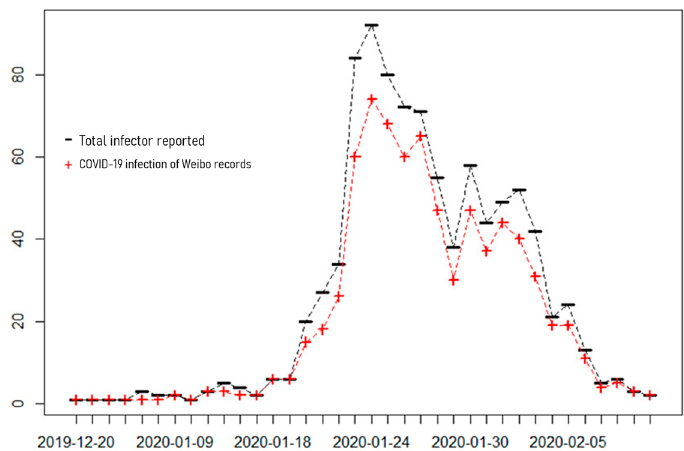
Figure 10. Timing chart of COVID-19 infection of Weibo records and total infector reported